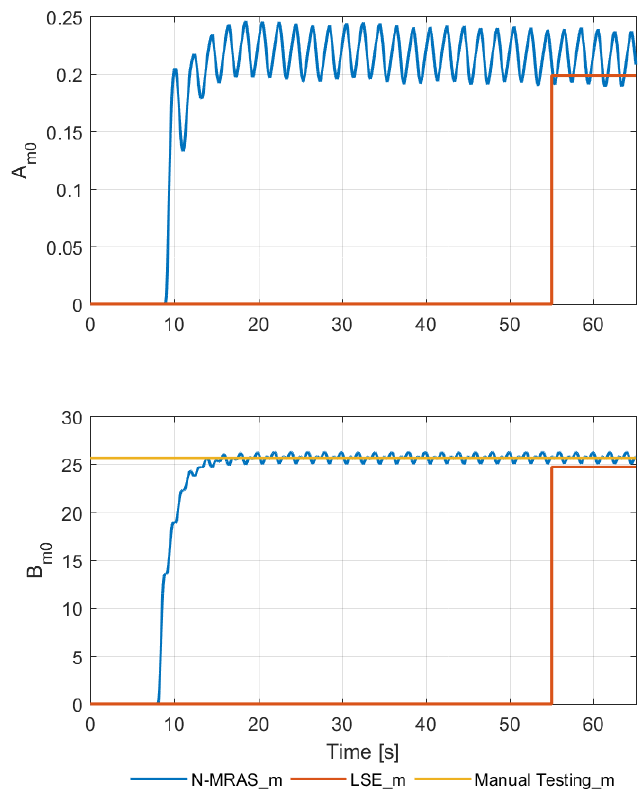
Figure 17. Comparative results for the intermediate mechanical parameters